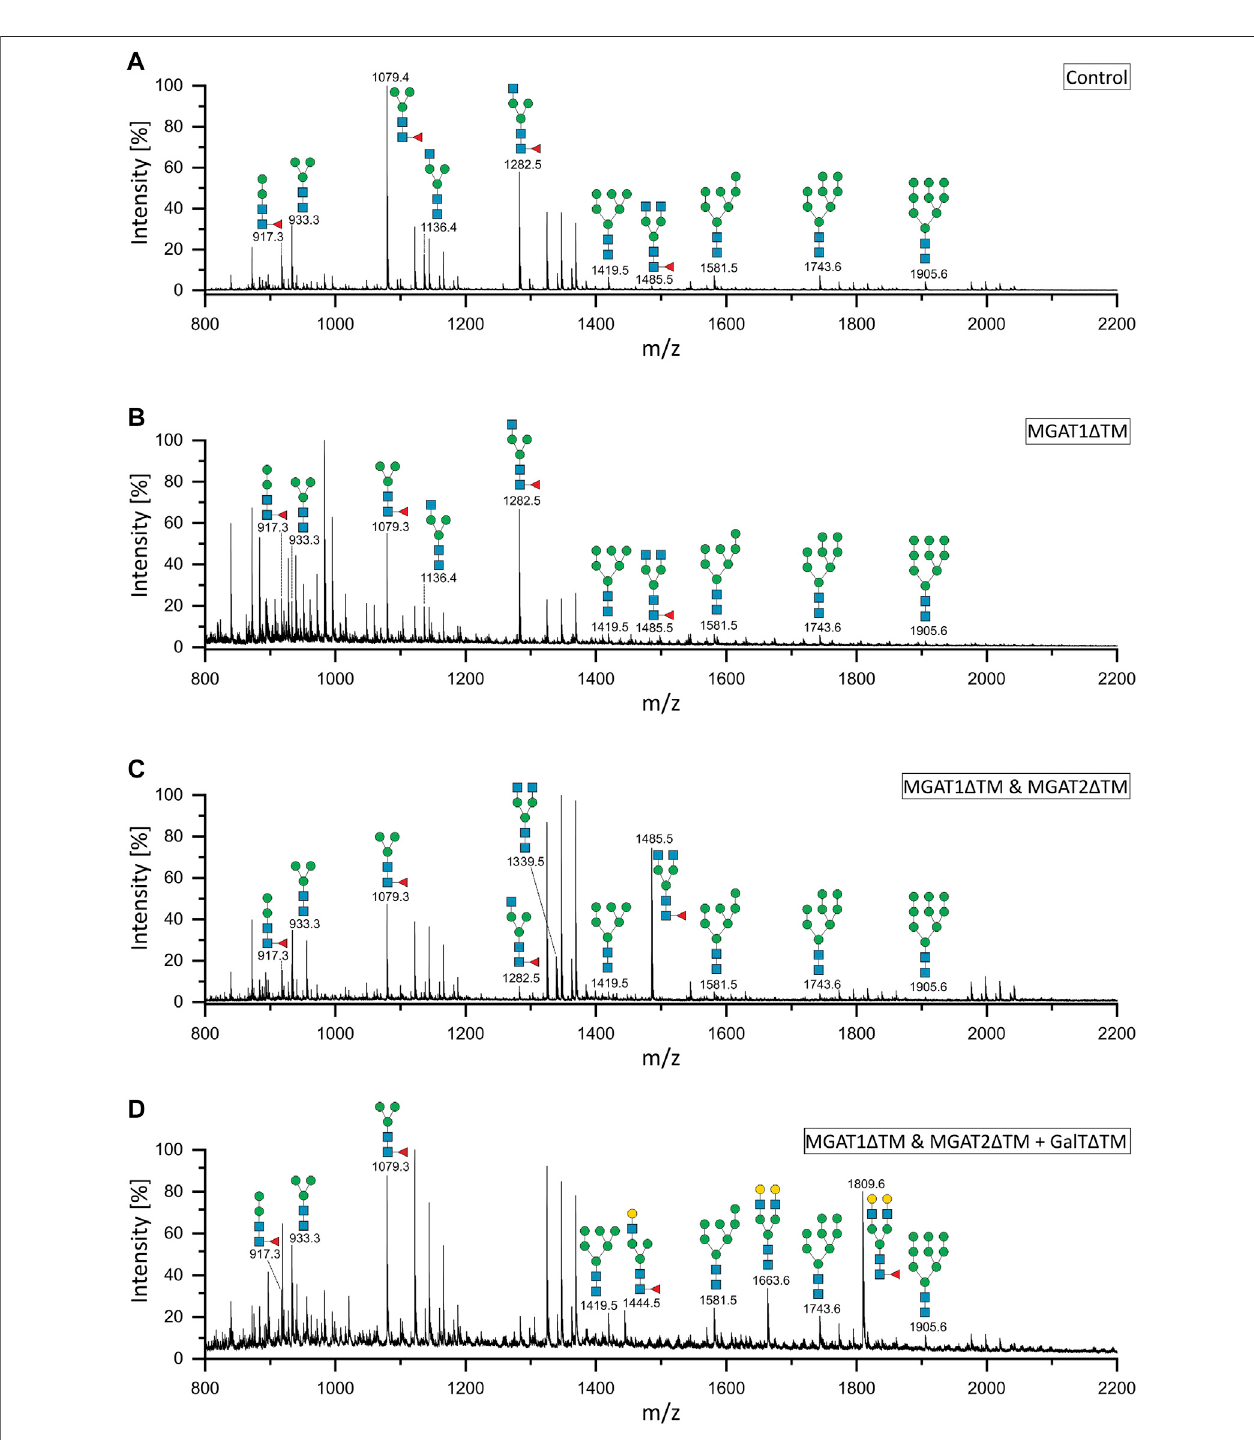
FIGURE 3 | MALDI-TOF mass spectra of the unprocessed and glycoengineered SARS-CoV-2 spike protein glycoforms. N -glycans were detected in re fl ectron positive ion mode as sodium adducts [(M + Na)+]. (A) Unprocessed spike protein. (B) 12 h after start of the reaction with MGAT1 Δ TM. (C) 12 h after the addition of MGAT2 Δ TM. (D) 12 h after the addition of GalT Δ TM. Only the peaks that depict N -glycans are annotated.